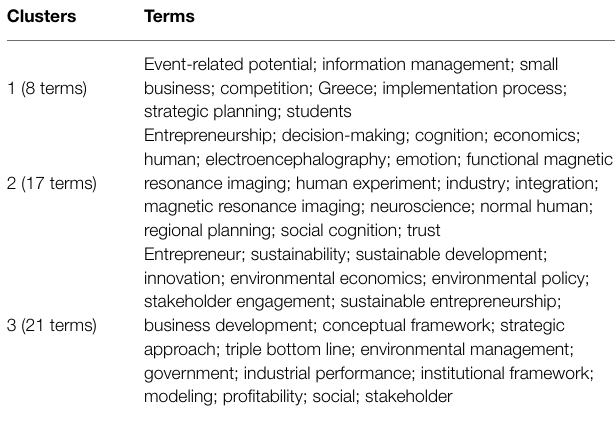
TABLE 7 | Knowledge community clusters in the field of